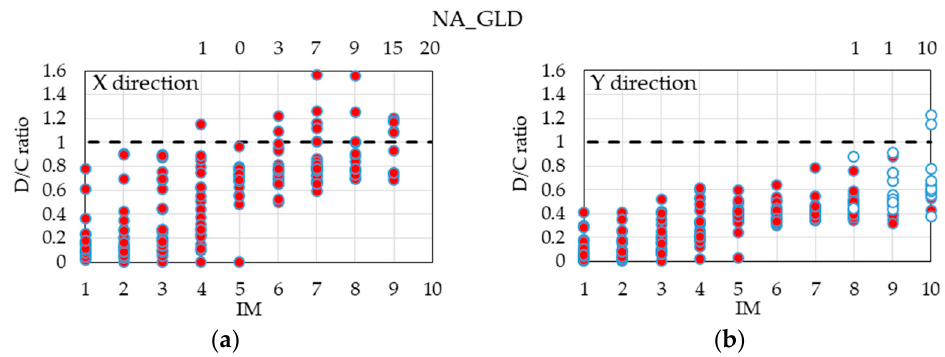
Figure 16. Displacement D/C ratios of the superstructure (UPD): NA_GLD X ( a ) and Y ( b ) directions.